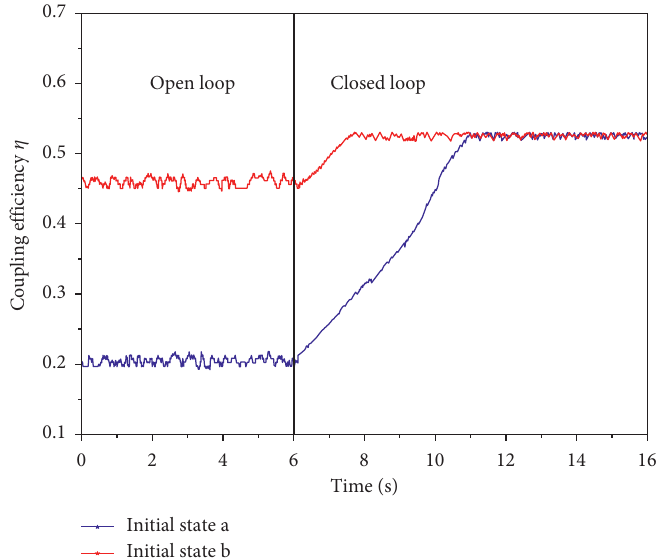
Figure 9: Open-loop and closed-loop coupling efficiency curves of the SMF coupling autoalignment